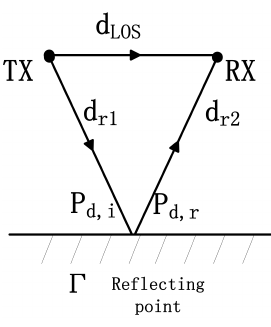
Figure 6. Illustration of the LOS (line-of-sight) path and a reflected